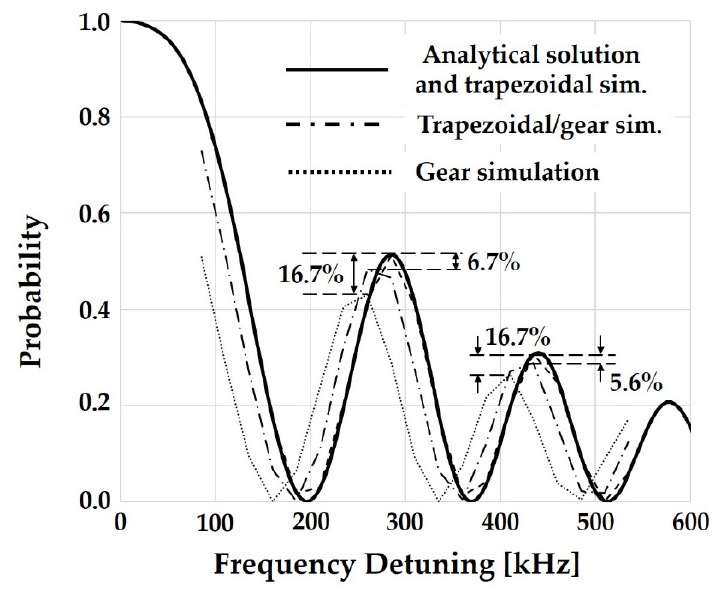
Figure 5. 35 kHz frequency compensated simulated chevron cross-sections vs. analytical chevron cross-section for P 0 for the second peak of the Rabi oscillation ( τ p = 5.067 µ s) in the case of different integration